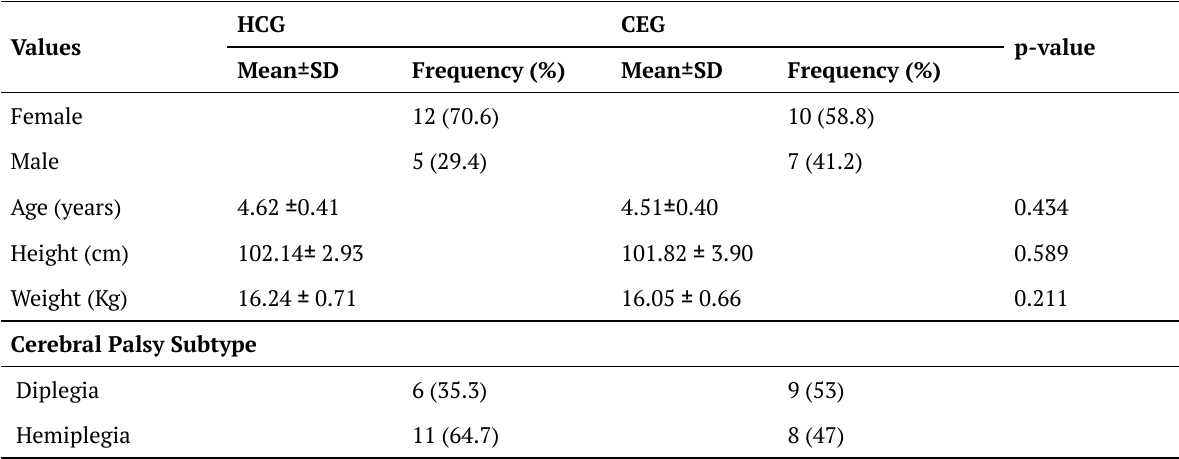
Table 2. Baseline characteristics of participants from both groups.